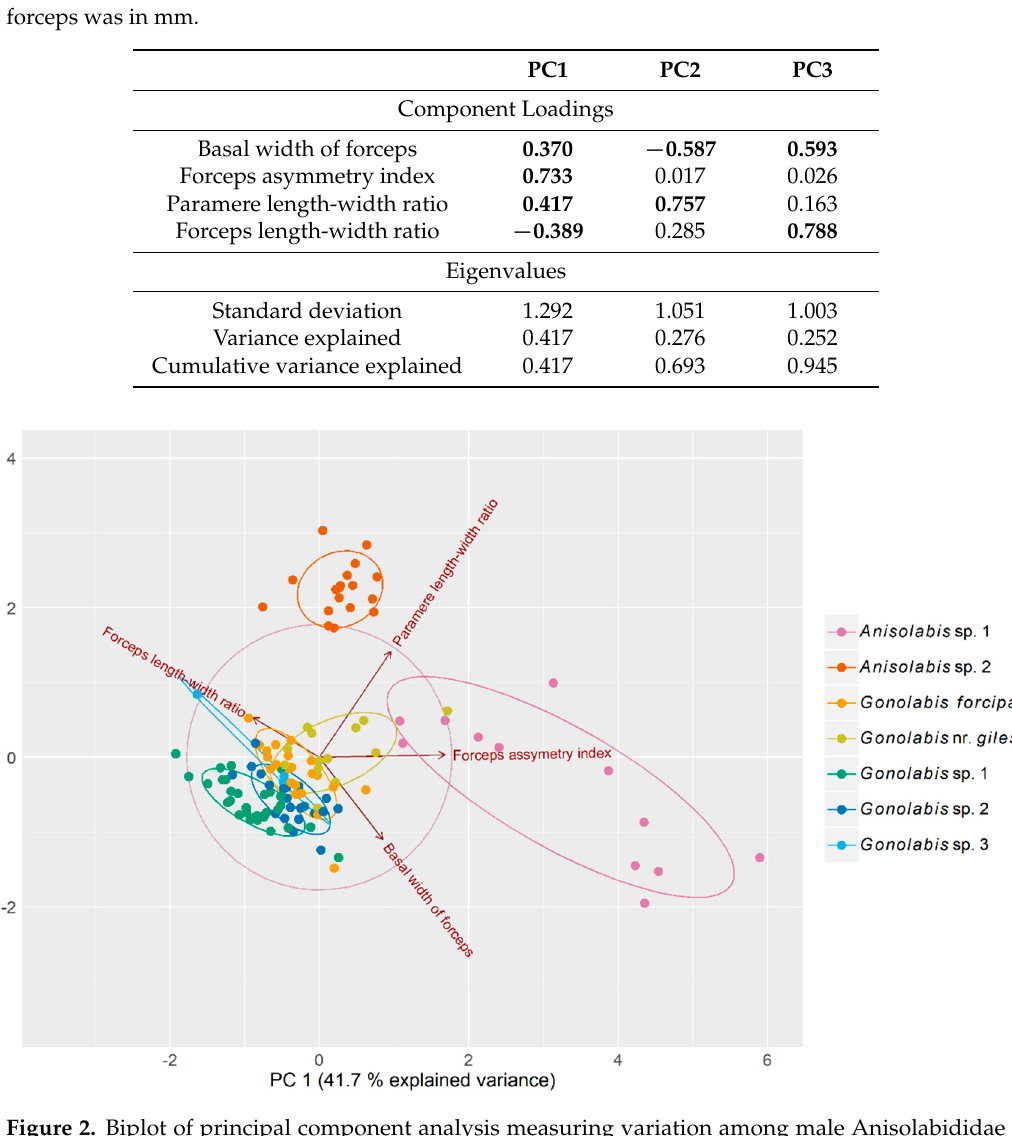
Figure 2. Biplot of principal component analysis measuring variation among male Anisolabididae specimens for seven morphometric variables related to primary and secondary male sex characteristics. Ellipses represent 68% normally distributed confidence intervals for the principal components plotted to aid visualisation of clusters. Vectors with arrows represent loadings of the variables on the principal components. Their direction relative to the x- and y-axes and each other represents their correlations with each principal component and each other. Orthogonal vectors are not correlated and vectors in opposing directions are negatively correlated. The length of the vectors in relation to the correlation circle is a relative indicator of the quality of each variable’s representation in the